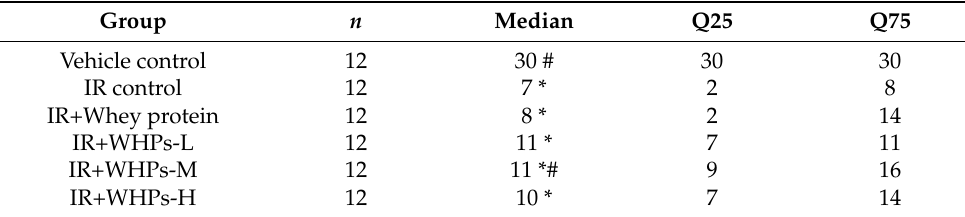
Figure 2. Kaplan–Meier survival curves of mice in each group. IR, irradiated mice; IR+WHPs-L, irradiated mice+low-dose whey hydrolysate peptides; IR+WHPs-M, irradiated mice+medium-dose whey hydrolysate peptides; IR+WHPs-H, irradiated mice+high-dose whey hydrolysate peptides. Table 2. Effect of WHPs on survival time (day) after